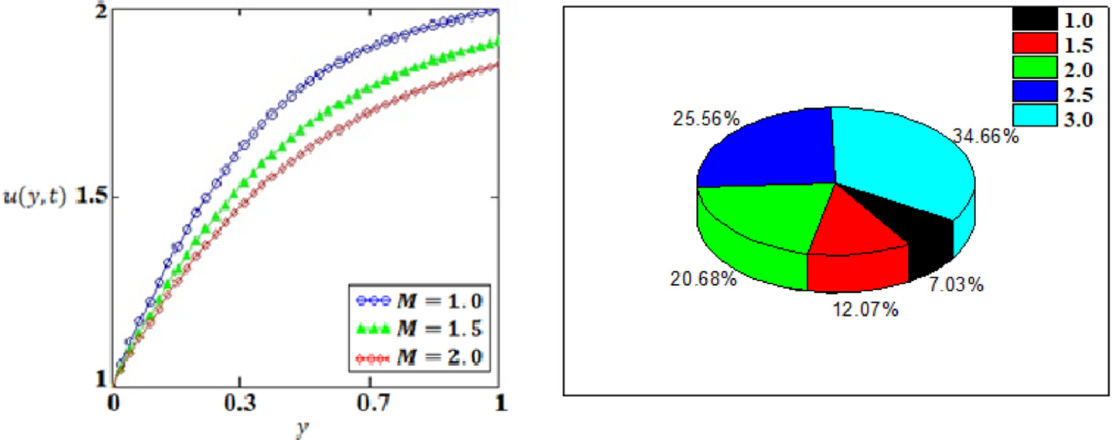
Figure 2. Graphical illustration of fractional approach of Caputo-Fabrizio with R 0 = 1, K 0 = 0.9, ZT 0 = 4.2, ω = 0.5, t = 1, α = 0.6, Pr = 15 for different magnetic parameter values.